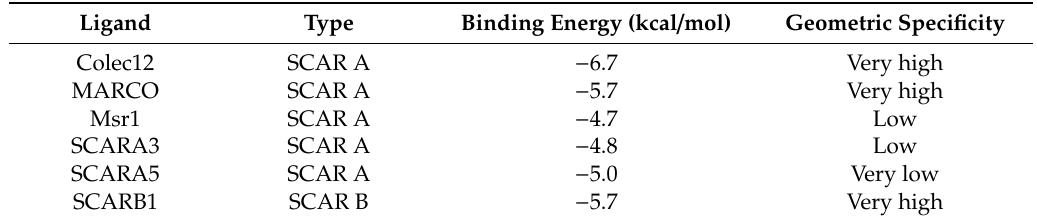
Figure 6. Chemical structure of S-allylmercaptoglutathione drawn in Gauss View Version 5 [31]. Table 2. Binding energies of GSSA to scavenger receptors type A (Colec12, MARCO, Msr1, SCARA3, SCARA5) and type B (SCARB1).